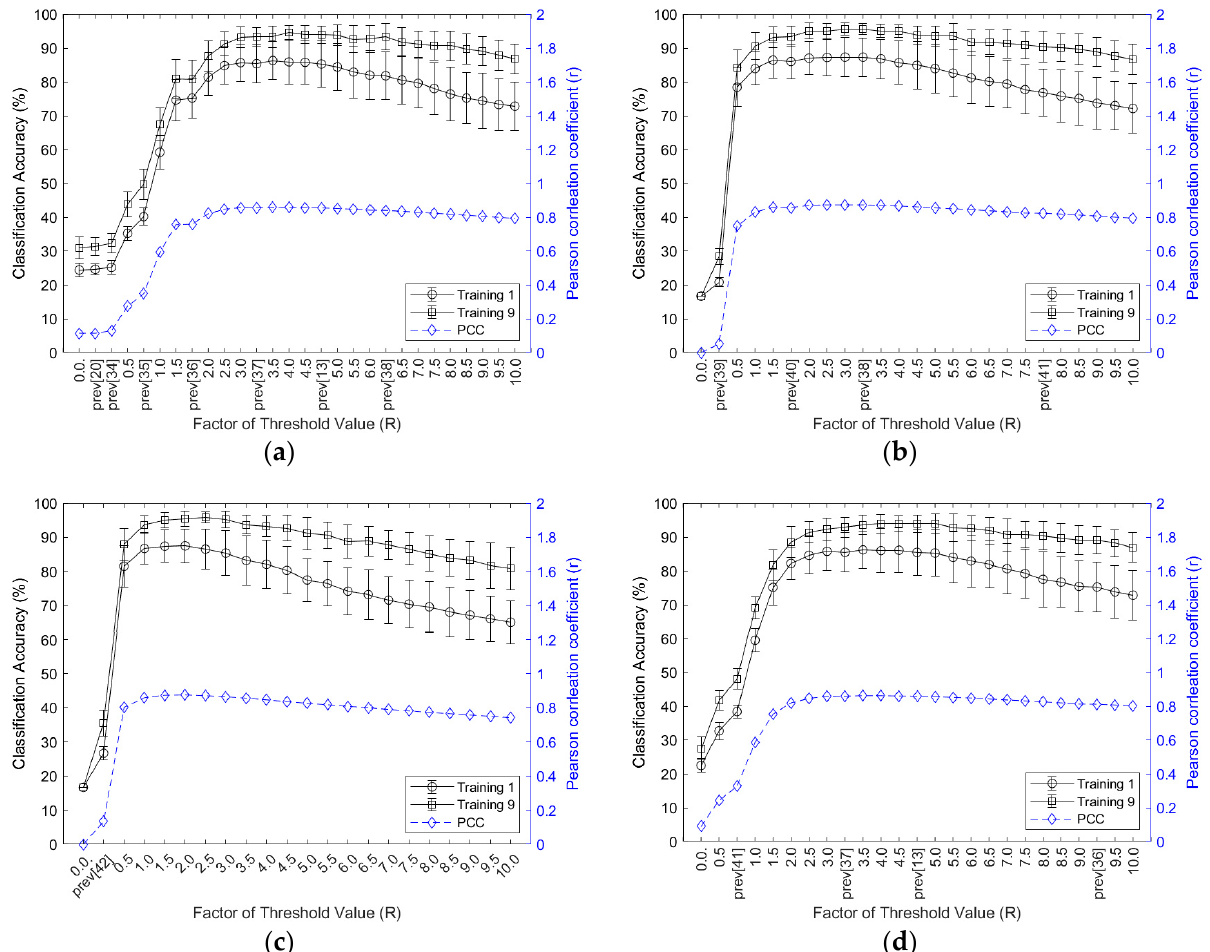
Figure 3. Classification accuracy and inter-session PCC of Group 1 based on threshold values: ( a ) ZC; ( b ) WAMP; ( c ) MYOP; ( d ) SSC; prev: threshold value from the previous study.